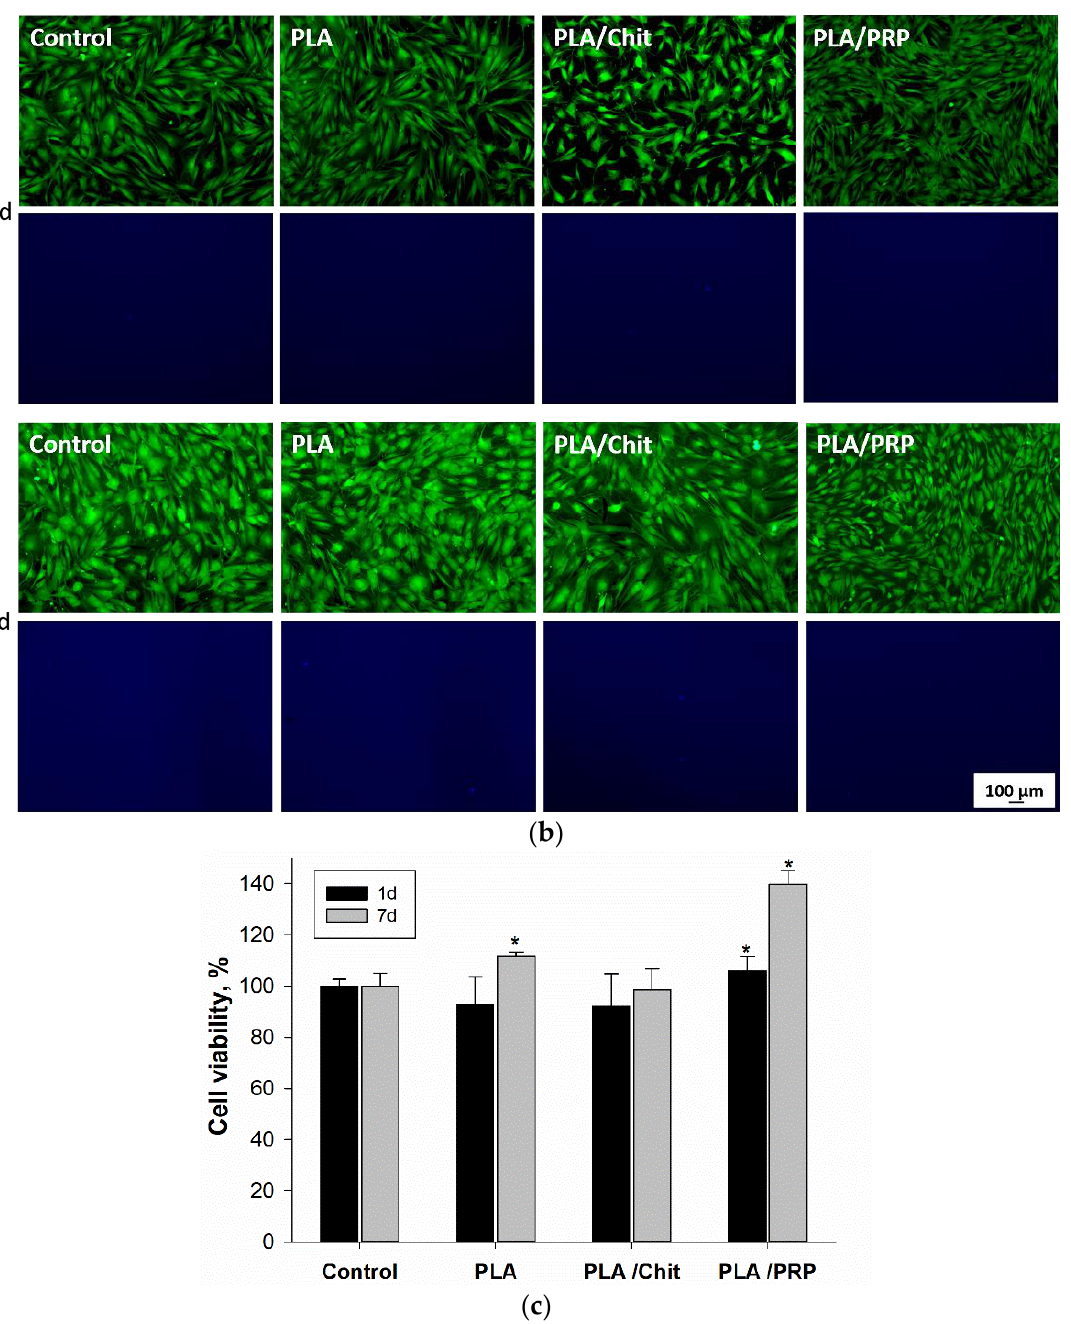
Figure 2. In vitro cytocompatibility of matrices: ( a ) adhesion of MSCs to PLA granules, SEM; ( b ) assessment of cytotoxicity of matrices using fluorescent microscopy of live MSCs stained with calcein AM (green) and dead cells stained with DAPI (blue); and ( c ) viability assessment of MSCS at 1 and 7 days after incubation with the matrices, MTT-test. * p < 0.05 (relative to control). The formation of granulation tissue with young fibroblasts, full-blooded vessels and small amounts of leukocytes, lymphocytes and giant cells of foreign bodies surrounding the PLA granules was observed 28 days after intramuscular implantation of the matrices (Figure 3a). Collagen fibers of connective tissue replaced chitosan hydrogel and PRP-based fibrin hydrogel. PLA granules were resorbed by giant cells of foreign bodies. There was no statistically significant difference in the number of giant cells of foreign bodies for the different matrices and, accordingly, the intensity of resorption of PLA granules (Figure